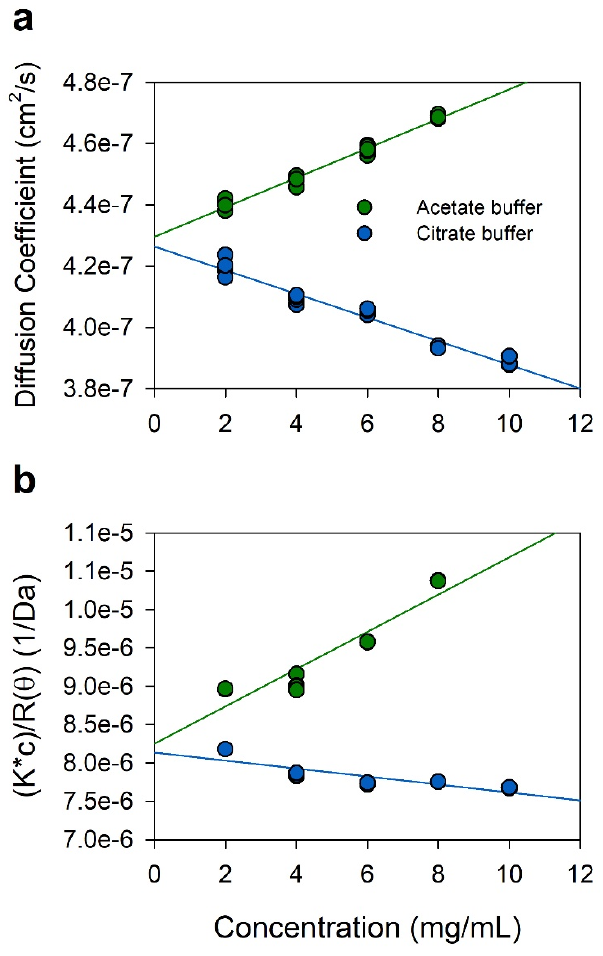
Figure 7. Protein–protein interactions in acetate buffer (green) and citrate buffer (blue) at pH 4.6. ( a ) The diffusion interaction parameter ( k D ) analysis by DLS; ( b ) the second virial coefficient ( A 2 ) measured by SLS. Values were obtained from quintuplicate measurements.